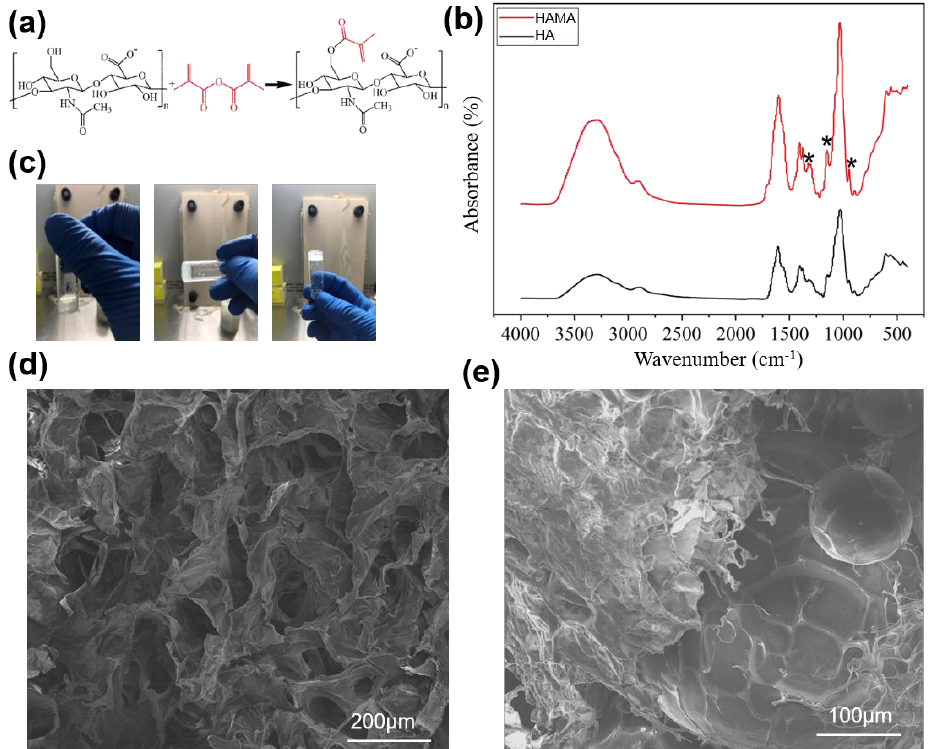
Figure 3. Fabrication and characterization of the microsphere/hydrogel system: ( a ) schematic illustration of the synthetic HAMA; ( b ) FTIR spectra of HA and HAMA hydrogels, where * represents the peak of the stretching vibrations of the C – O bond and C – O – C ether bond, and the bending vibration of the C=C bond; ( c ) gelation of the HAMA hydrogel; ( d ) SEM images of the internal structure of the HAMA hydrogel; and ( e ) SEM images of the microsphere/hydrogel system. Abbreviations: HA, hyaluronic acid; HAMA, methacrylated hyaluronic acid.